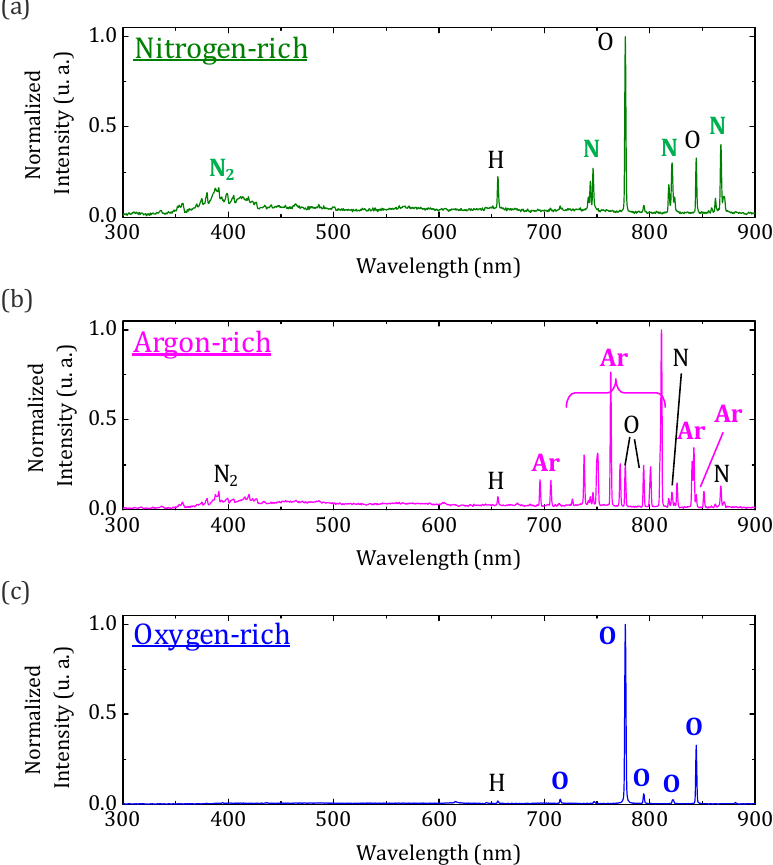
Figure 3. Typical emission spectra collected from the device placed under ( a ) nitrogen-rich, ( b ) argon-rich, and ( c ) oxygen-rich gas flow.